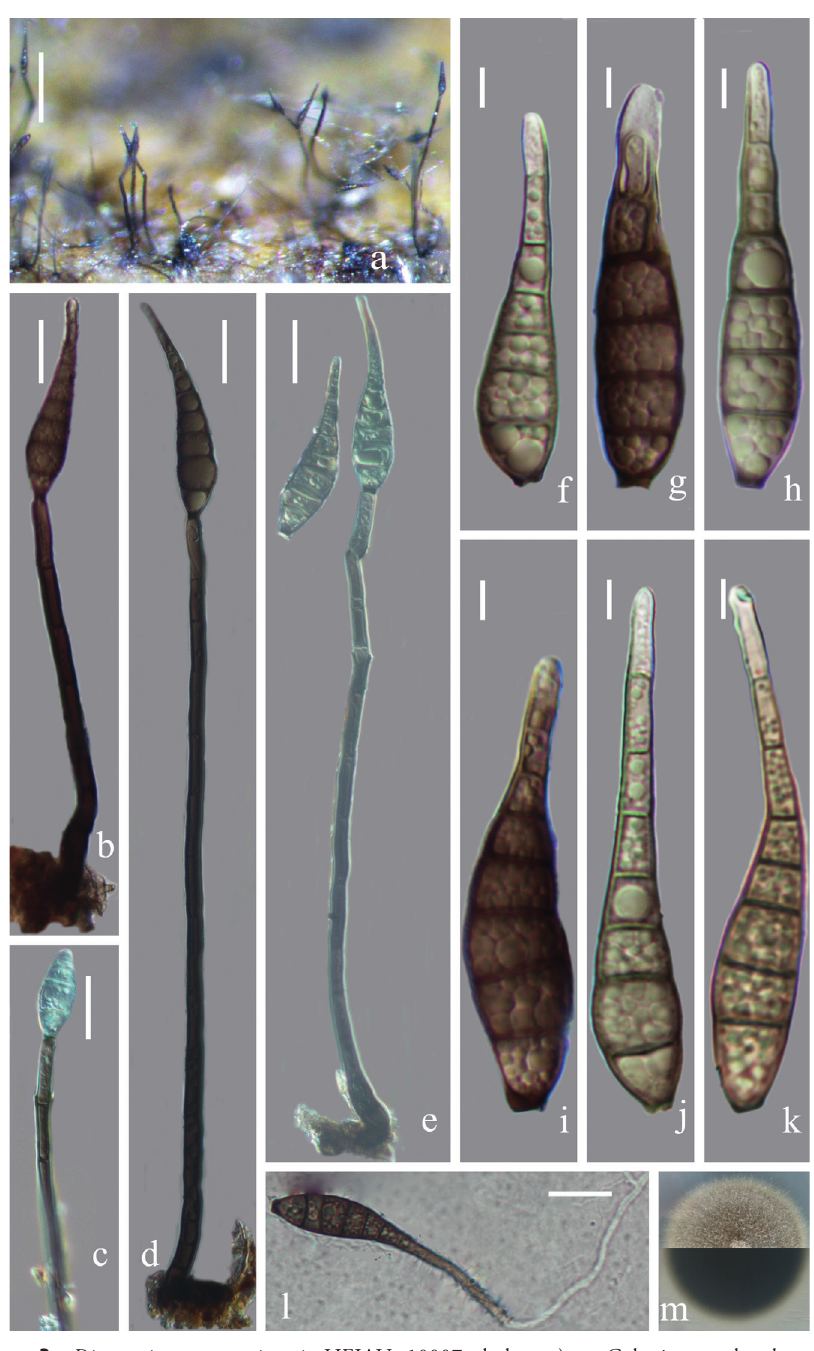
Figure 3. Distoseptispora yongxiuensis HFJAU 10007, holotype) a Colonies on bamboo culm b, d conidiophores with conidia c conidiogenous cell bearing conidium e conidiogenous cells with young conidia f-k conidia l germinating conidium m culture on PDA from above and reverse. Scale